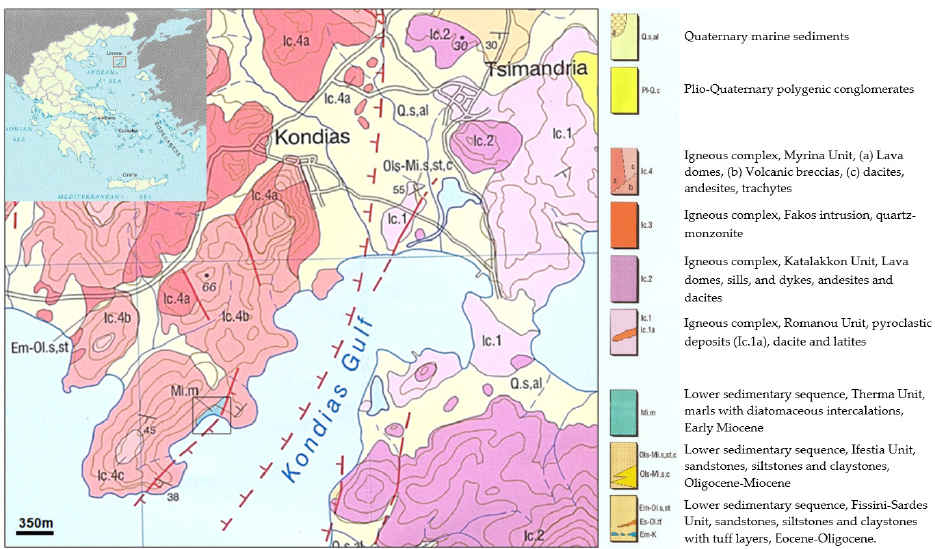
Figure 1. Geological map of the study area on Limnos Island [26] (Reprinted/adapted with permis- sion from Prof. M. Fyticas).